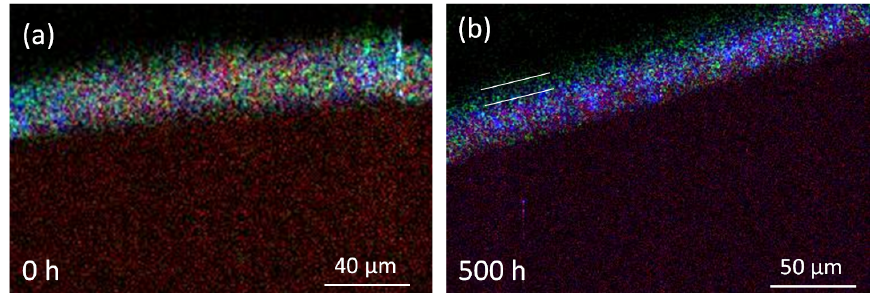
Figure 12. Three ‐ colour maps of sections of the coating prior to NSS exposure and after 500 h exposure to NSS. These maps are combined PIGE (Li–Red) and PIXE, (Sr in Blue and Ba in green). Three colour elemental maps for Li ‐ Cu ‐ Ba ( a ) without NSS exposure and ( b ) after 500 h NSS exposure.